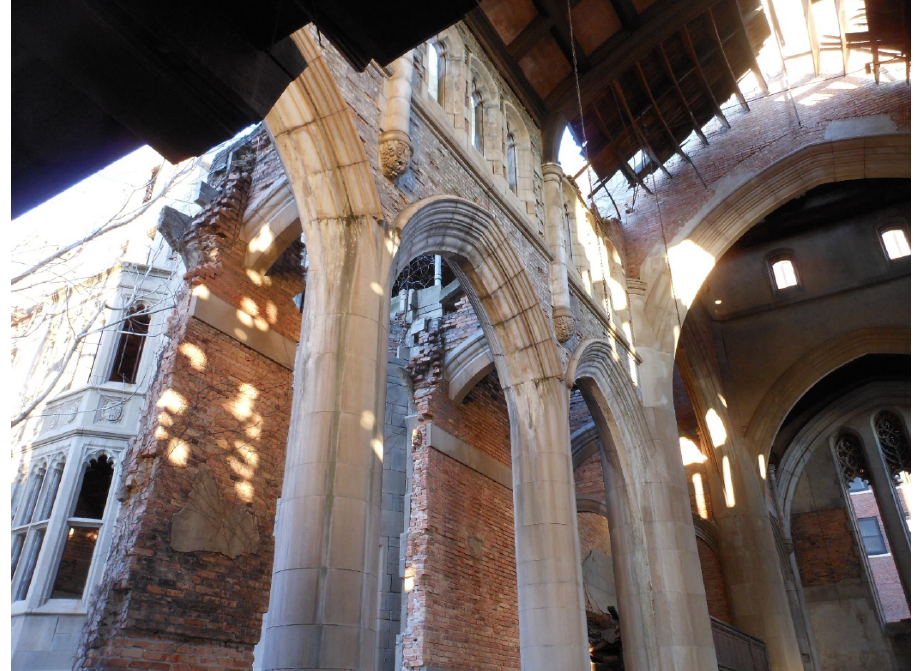
Figure 1. Gary Methodist Church Sanctuary in Gary, Indiana (Photo courtesy of Ball State University undergraduate architecture student Shannon